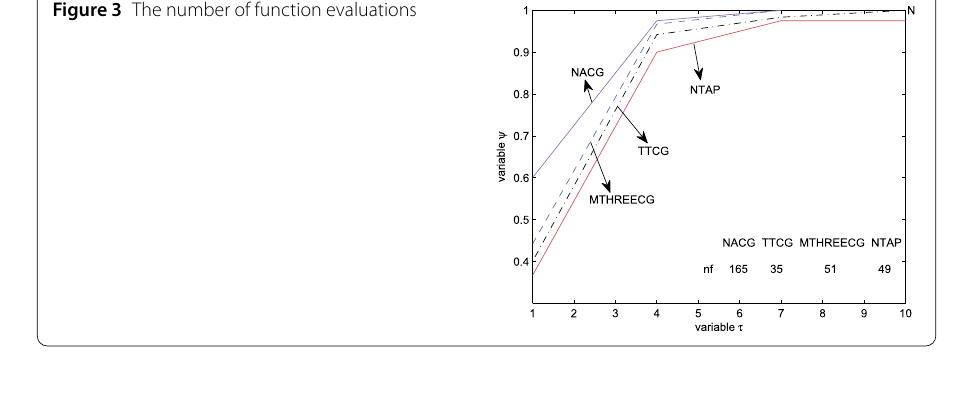
Figure 4 The number of gradient